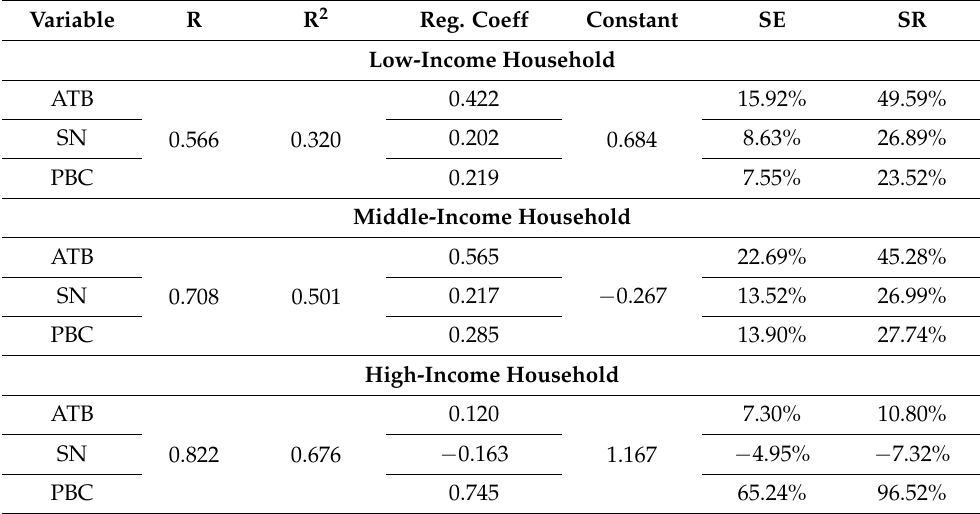
Table 4. The effect of ATB, SN, and PBC towards I among low-, middle-, and high-income